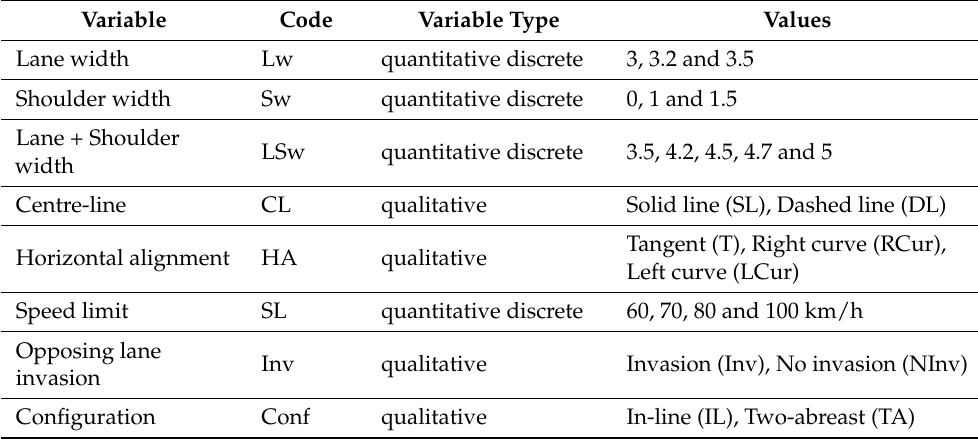
Table 1. Variables related to road geometry and configuration of group of